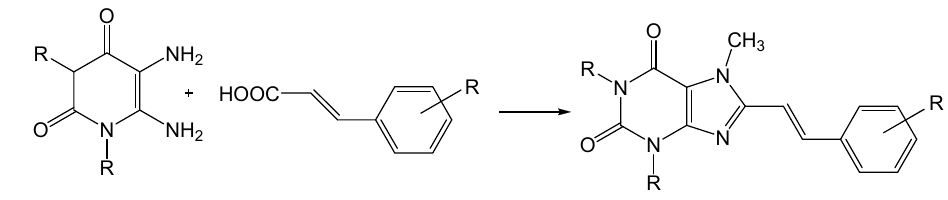
Figure 6. Synthesis route of styrylxanthines such as istradyfilline.